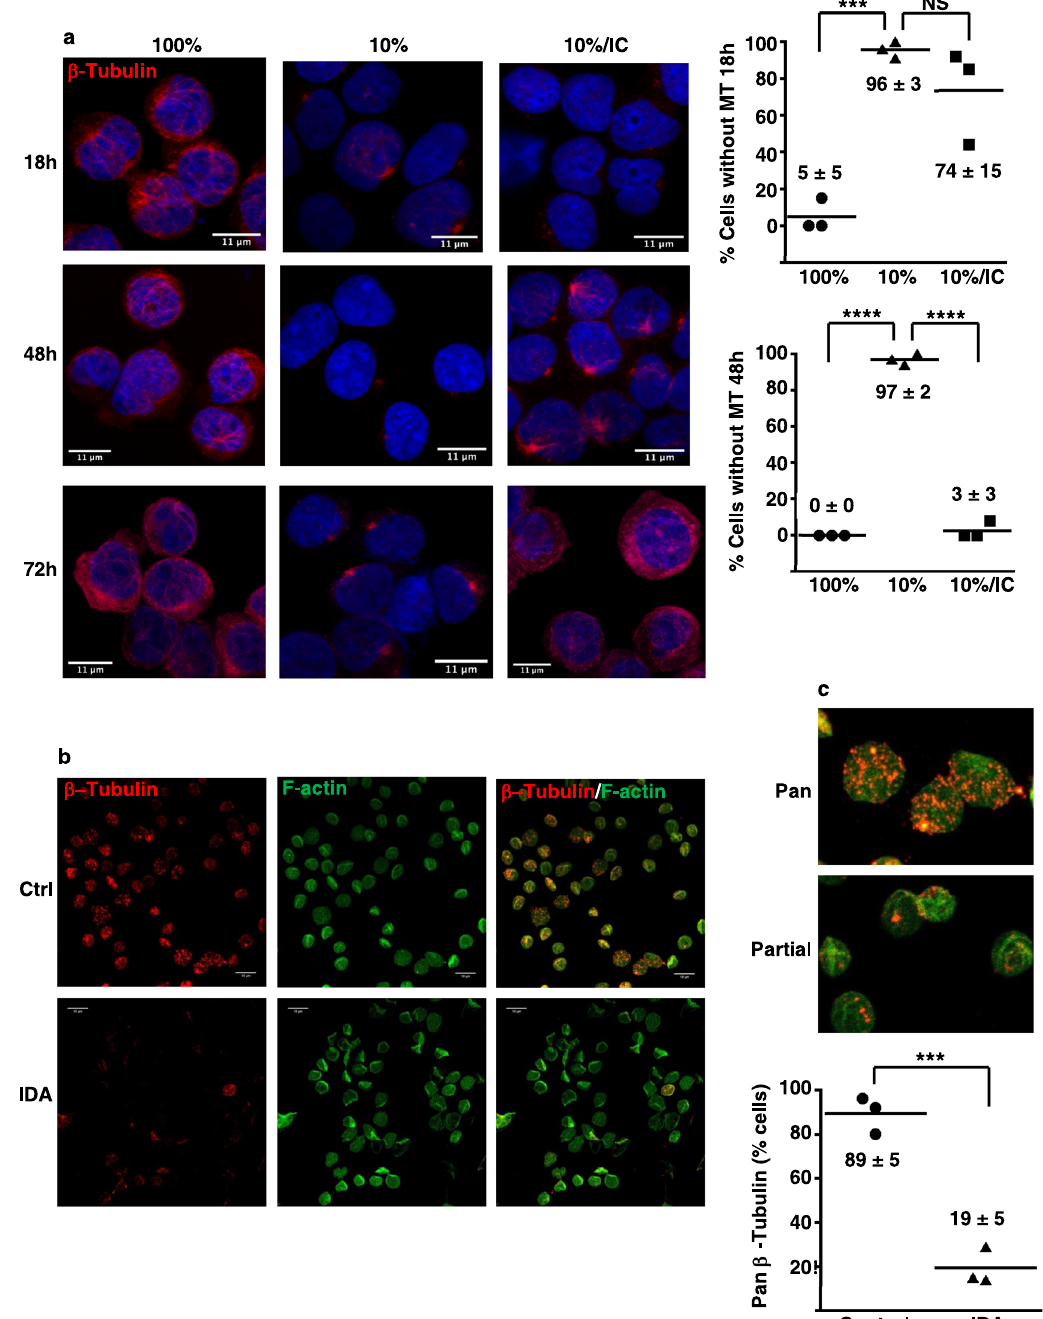
Fig. 2 Microtubule disruption associated with erythroid iron restriction. a Microtubule alterations demonstrated by immuno fl uorescence on human CD34 + progenitors cultured 1 – 3 days in iron-replete (100% TSAT) or de fi cient (10% TSAT) erythroid medium ± isocitrate rescue (IC). Red: β -tubulin; blue: DAPI. Graphs: % cells with undetectable microtubule structures (MT) on days 1 and 2. Numbers indicate mean ± SEM; n = 3 biologically independent experiments; ***, **** P = 0.001, 0.0001, one-way ANOVA with Tukey post hoc test. b Alterations in human erythrocyte microtubule remnants demonstrated by fl uorescence staining of peripheral blood samples from an iron-replete non-anemic control (Ctrl) and from a patient with iron de fi ciency anemia (IDA). White line, 10 µ m. Red: β -tubulin; green: fi lamentous (F) actin. Representative results from three independent experiments. c Magni fi cation of images from b to illustrate the pancellular versus partial distributions of microtubule remnants characteristic of control versus IDA erythrocytes. Red: β - tubulin; green: fi lamentous (F) actin. Graph: % erythrocytes with pancellular microtubule remnants. Numbers indicate mean ± SEM; n = 3 independent samples per group; *** P = 0.003, unpaired two-sided Student ’ s t test. See also Supplementary Figs. 2 – 4. Source data are provided as a Source data fi